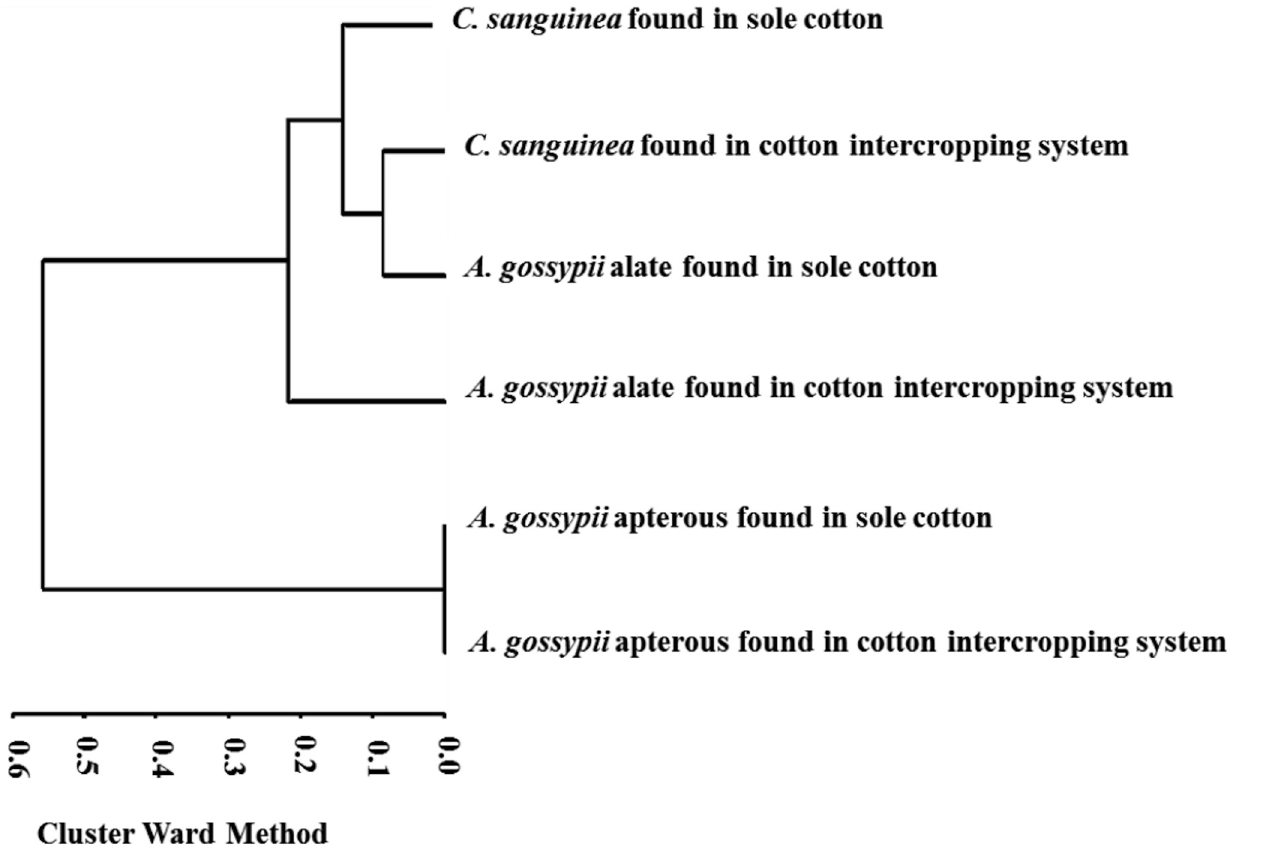
Fig 2. Co-occurrence of A . gossypii and C . sanguinea studied in sole cotton and intercropped